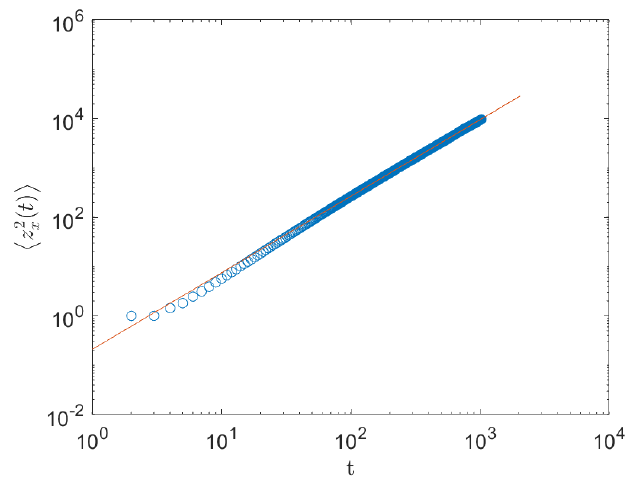
Figure 5. The MSD averaged by the stochastic processes formed by water flows from the initial sites is shown and the slope of the straight guide line represents H ≈